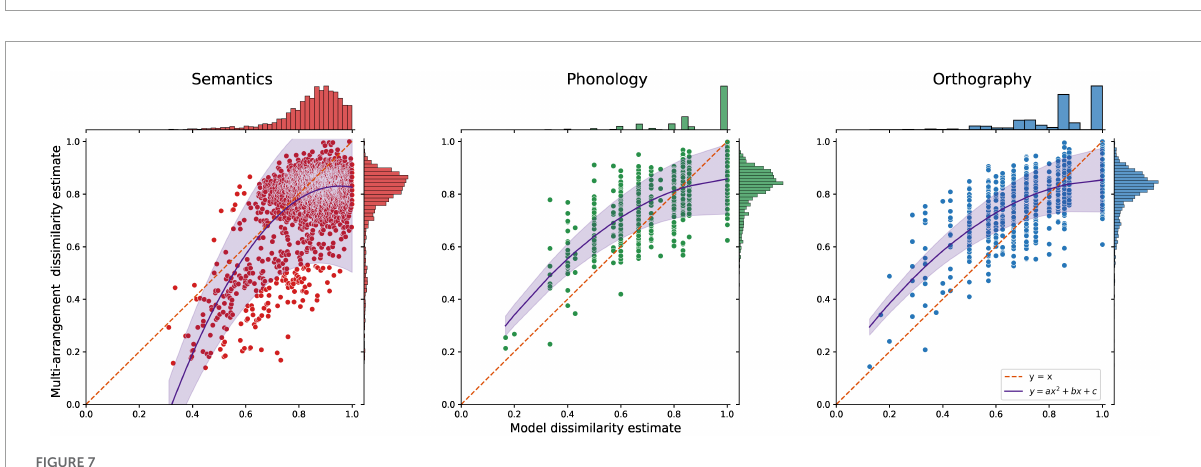
FIGURE7 The dissimilarity of all item pairs according to each modality’s model compared to behavioral group-level multi-arrangement results. The diagonal and a simple curve fit are added to show the skew of each modality. If the multi-arrangement data and the models agreed perfectly the data should lie on the diagonal; however, multi-arrangement tends toward lower dissimilarity compared to Word2Vec, but results in higher dissimilarity compared to Levenshtein